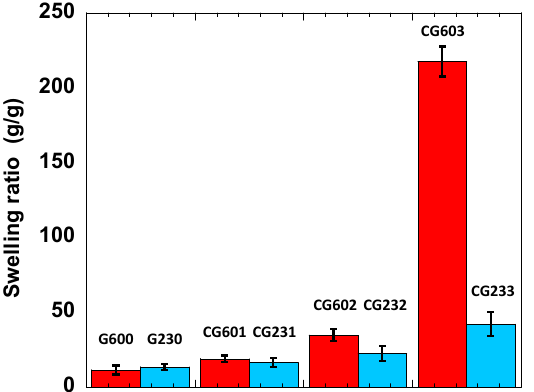
Figure 9. The swelling ratios of reference and crosslinked cellulose hydrogels, with CG 603 exhibiting the highest swelling ratio of 220 g/g.